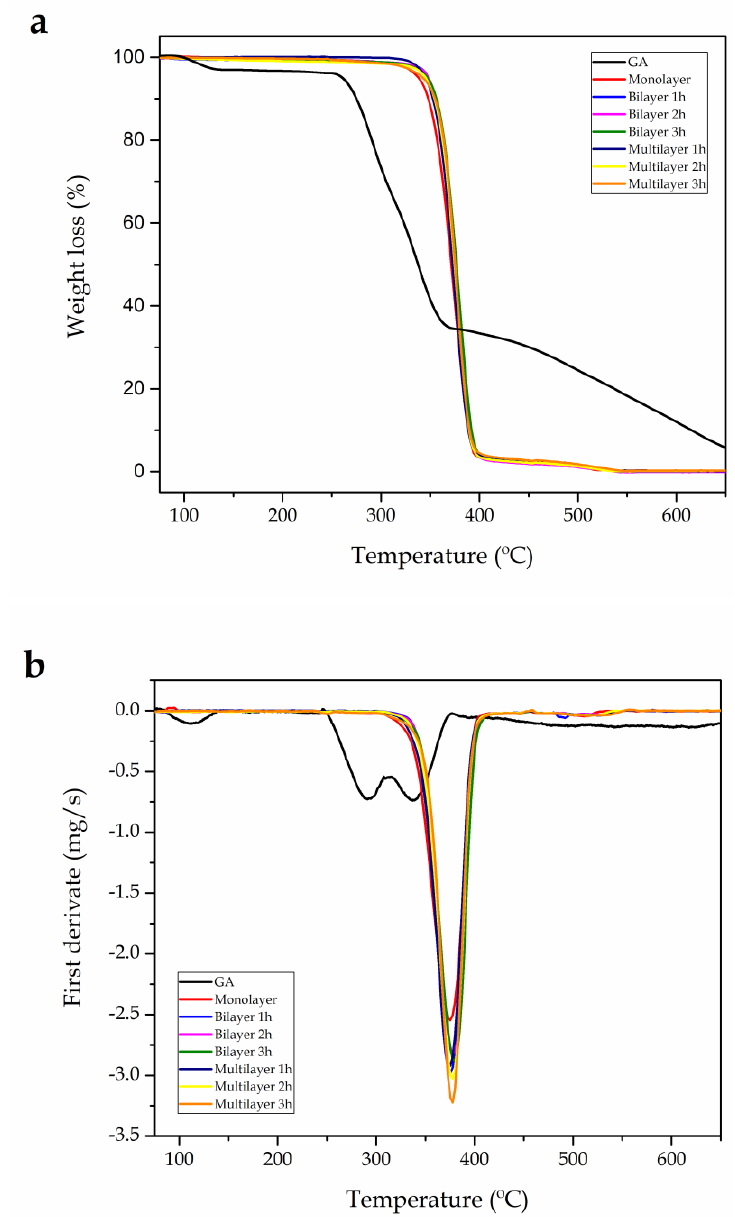
Figure 4. Comparative plot of the gallic acid (GA)-containing polylactide (PLA) films in terms of: ( a ) Thermogravimetric analysis (TGA) curves; and ( b ) first derivative thermogravimetric (DTG) curves.